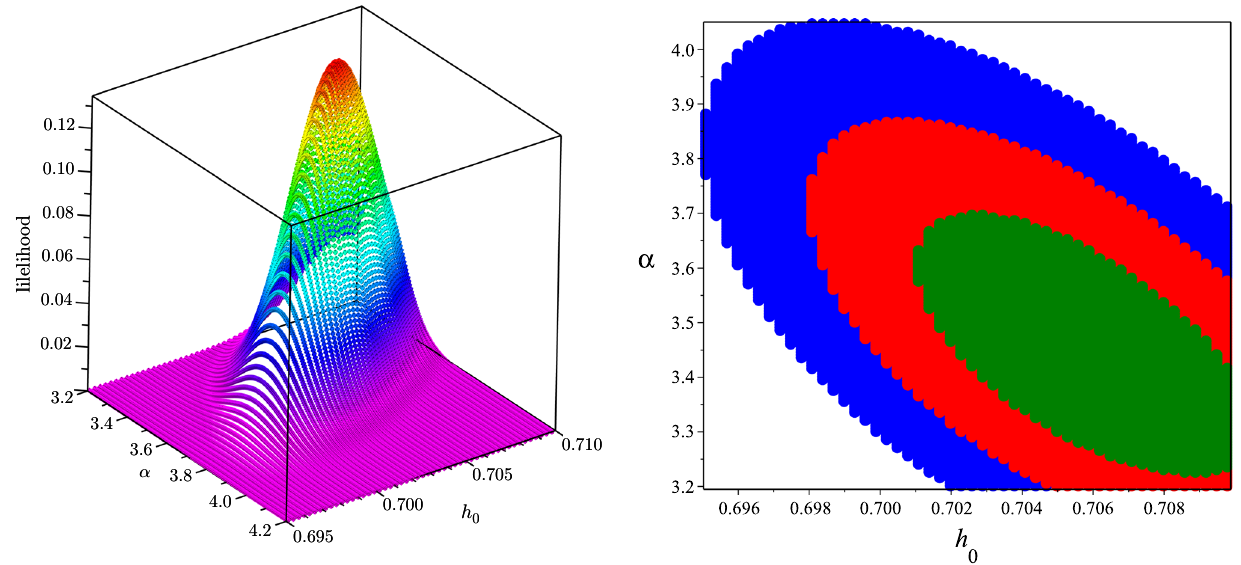
Fig. 1 The confidence region in 2-dim and 3-dim for the best fitted α and H 0